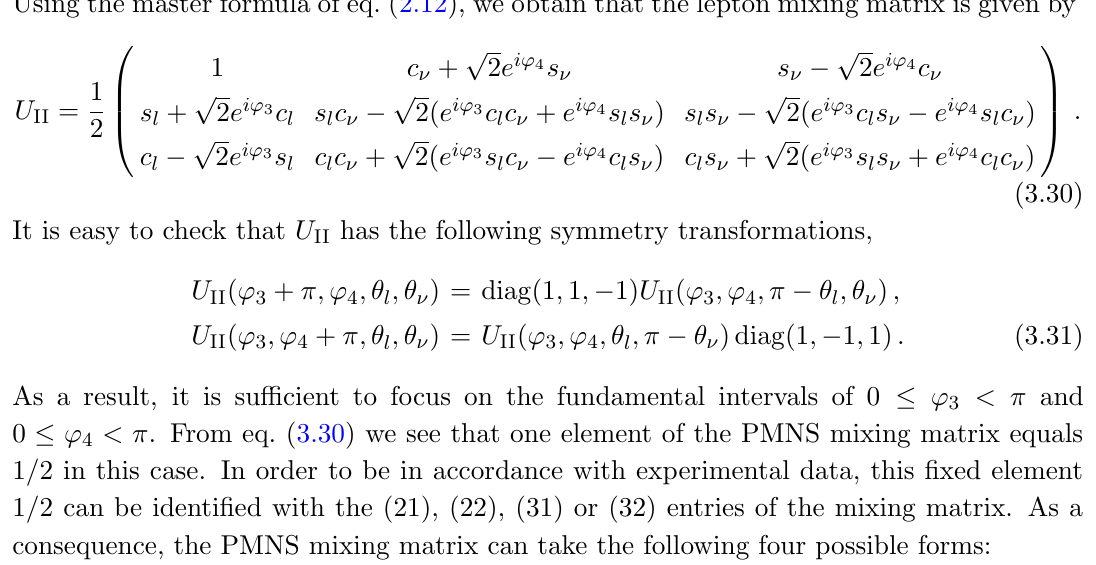
Figure 3 . The possible values of the e(cid:11)ective Majorana mass m ee as a function of the lightest neutrino mass m min for the mixing pattern U I ; 6 with n = 4. The red (blue) dashed lines indicate the most general allowed regions for IH (NH) neutrino mass spectrum obtained by varying the mixing parameters over their 3 (cid:27) ranges [8]. The present most stringent upper limits m ee < 0 : 120 eV from EXO-200 [85, 86] and KamLAND-ZEN [87] is shown by horizontal grey band. The vertical grey exclusion band denotes the current bound coming from the cosmological data of P m i < 0 : 230 eV at 95% con(cid:12)dence level obtained by the Planck collaboration